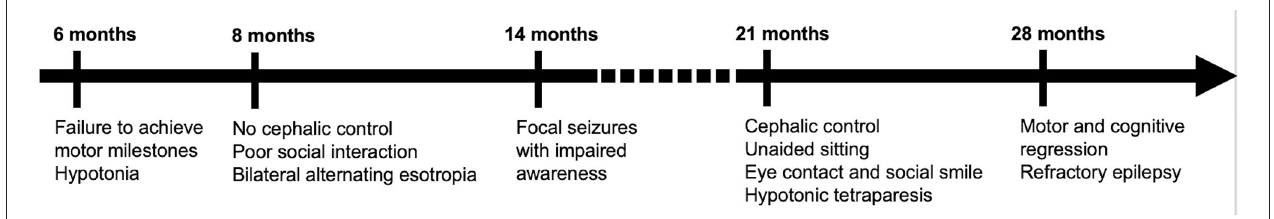
FIGURE 1 | Timeline of symptoms and signs.